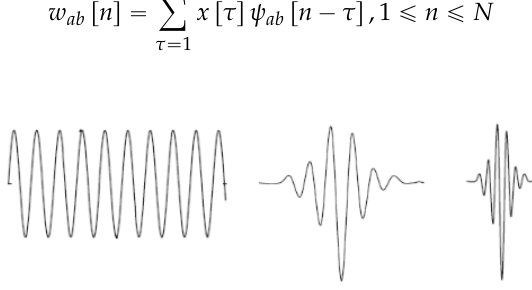
Figure 8. Sinusoid and two wavelets with different width.